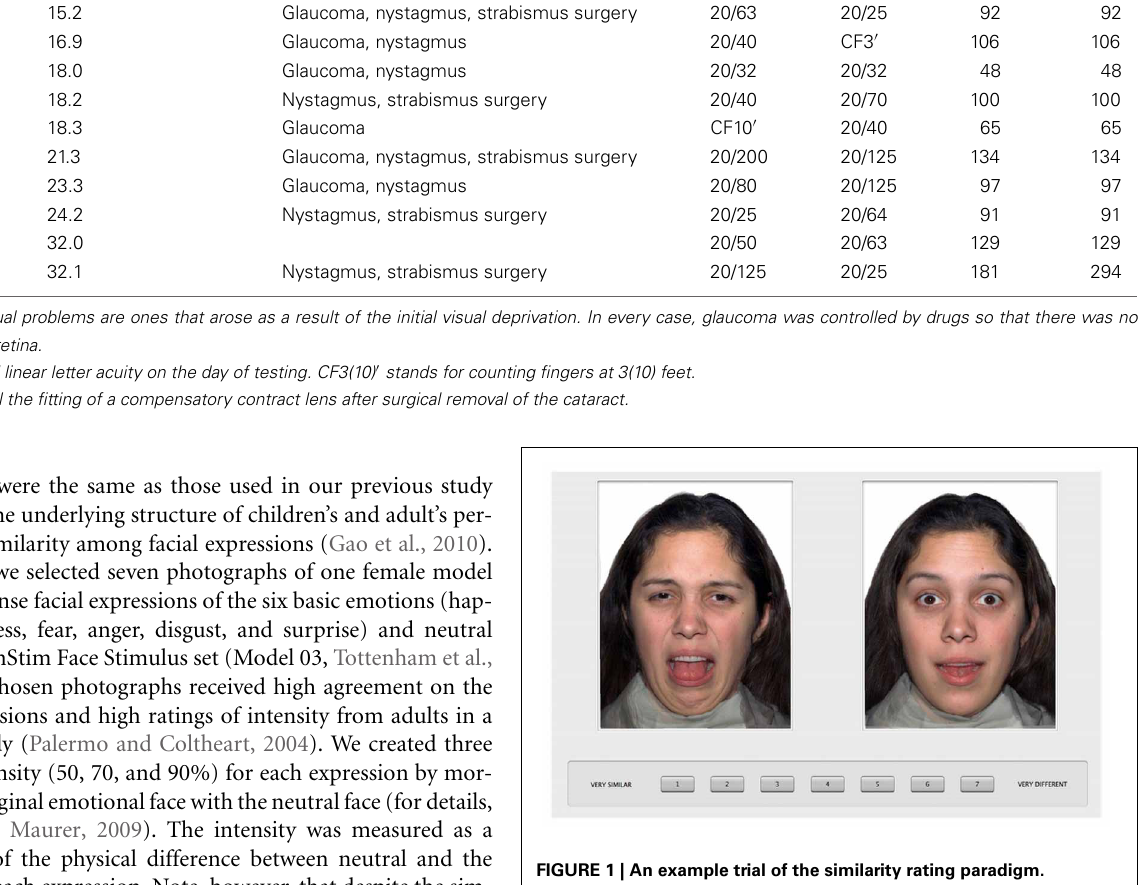
FIGURE 1 | An example trial of the similarity rating paradigm.